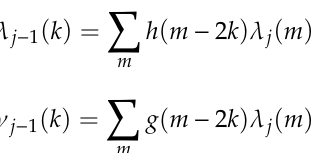
Figure 12. Wavelet block diagram of filter analysis—three level filter bank.